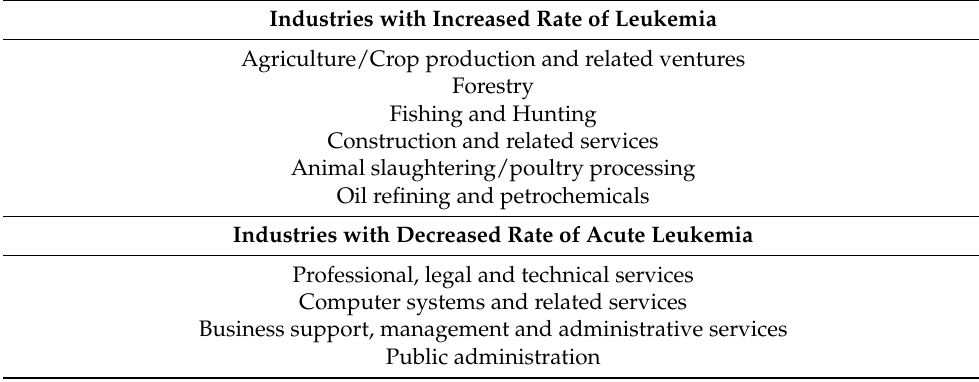
Table 2. Industries with Increased and Decreased Rate of Leukemia.